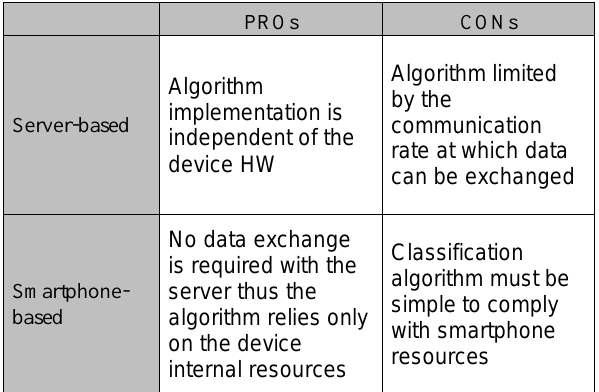
Table 1. PROs and CONs of server-based and smartphone-based solutions in the implementation of the classification